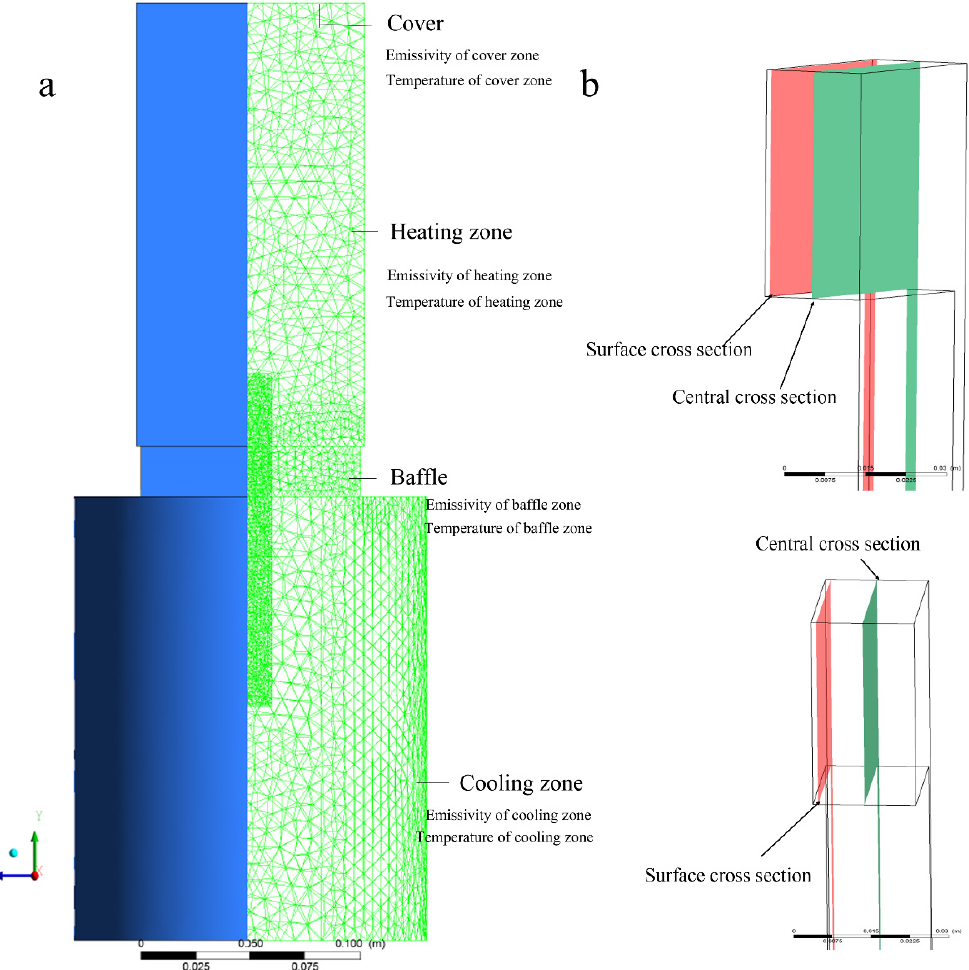
Figure 10. ( a ) Schematic representation of the computational domains and the meshes for the fur- nace heat transfer, and ( b ) the position of the surface and central cross sections in the casting. There are some assumptions in the DS process: (1) displacement current is ignored and time-harmonic electromagnetic field is assumed as quasistatic electromagnetic field; (2) flow in melt is laminar flow; (3) electromagnetic force affects fluid flow, but fluid flow has no effect on electromagnetic; and (4) alloy melt is incompressible Newton